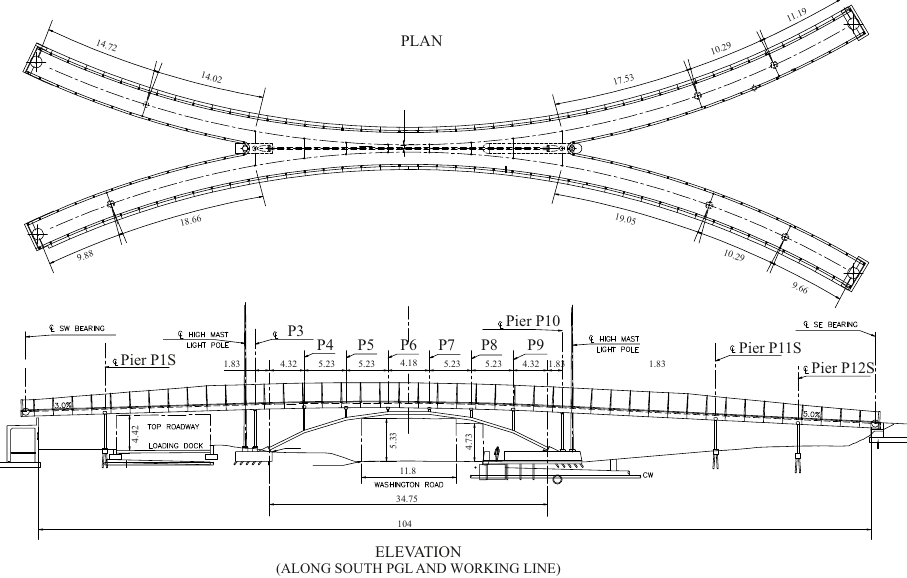
Figure 1. Plan and elevation view with Pier numbering. SI units. (Adapted from original drawings of Princeton University Facilities and